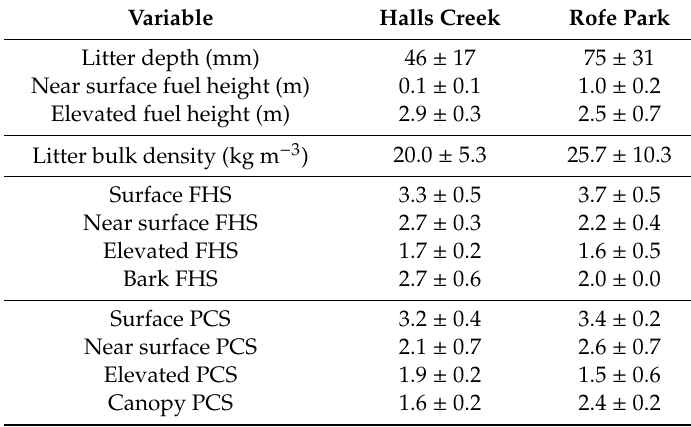
Table 3. Physical measurements and visual assessments of litter from Halls Creek and Rofe Park: litter depth, fuel height, bulk density, fuel hazard score (FHS) and percent cover score (PCS).